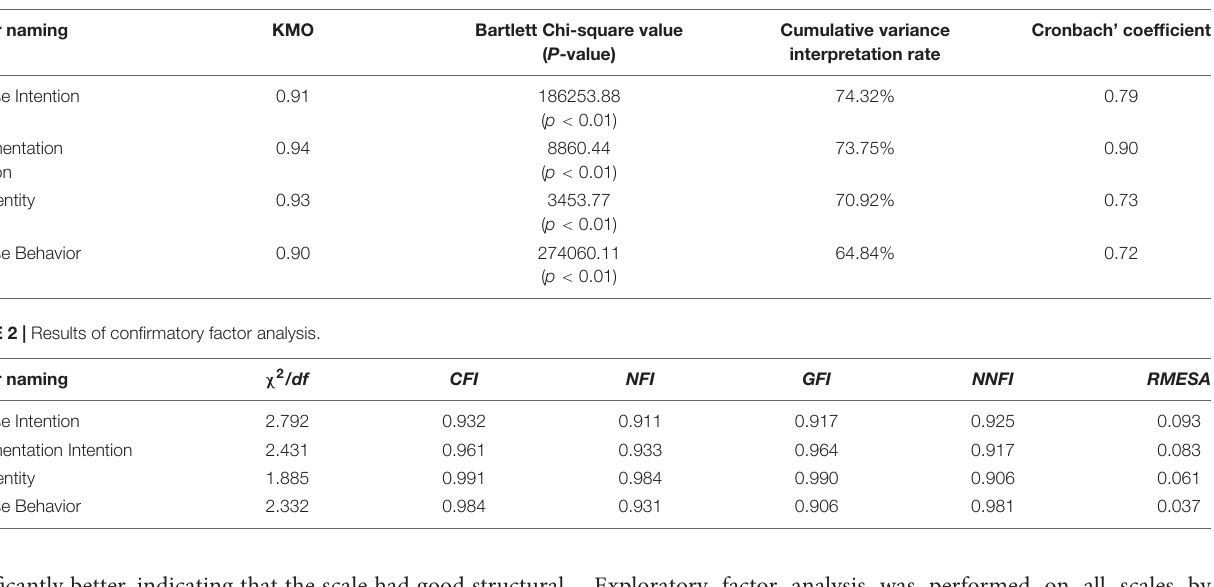
TABLE 1 | Results of exploratory factor analysis and internal consistency test.